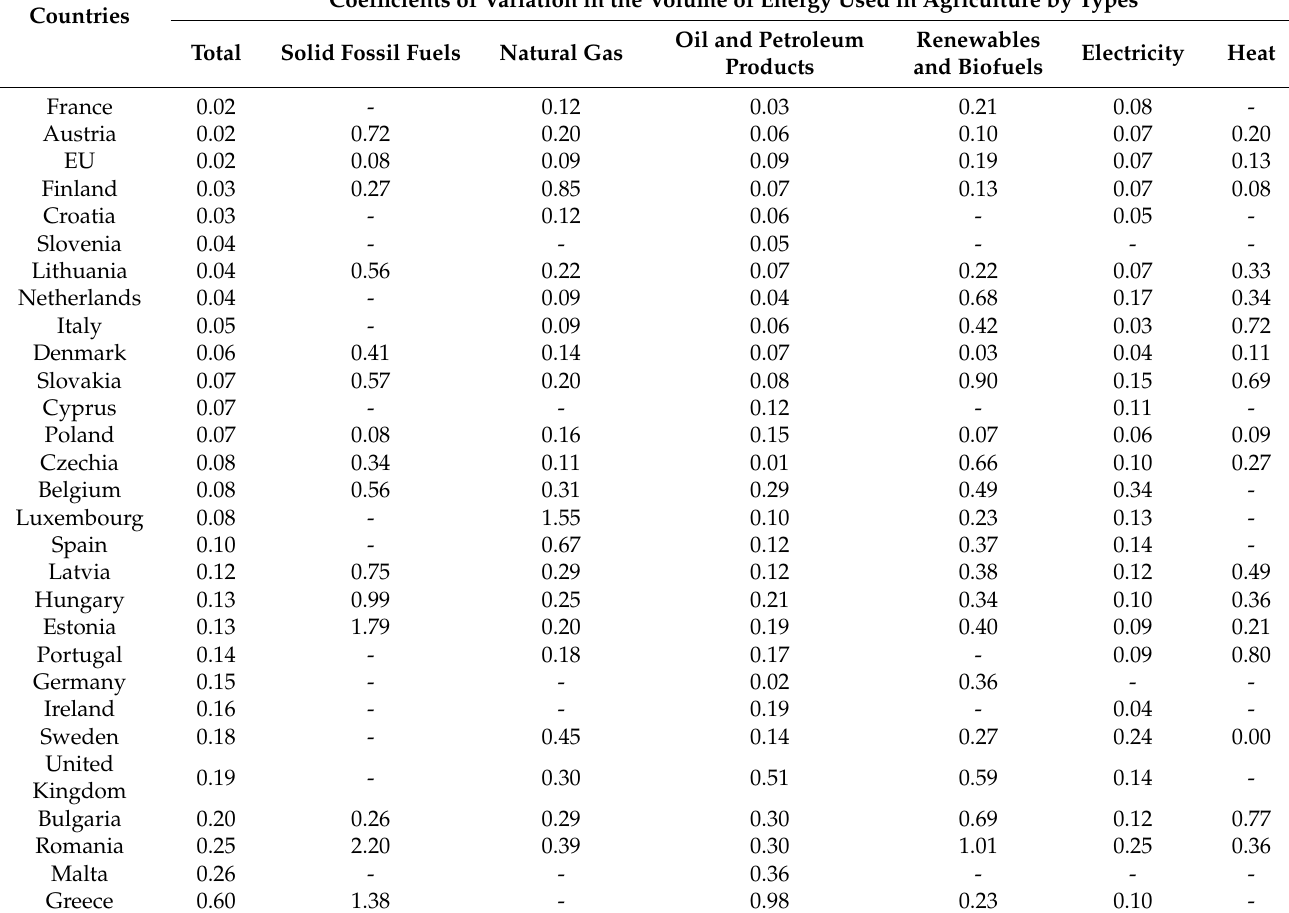
Table 3. Coefficients of variation of energy used in agriculture in EU countries in 2005–2018. Coefficients of Variation in the Volume of Energy Used in Agriculture by Types Countries